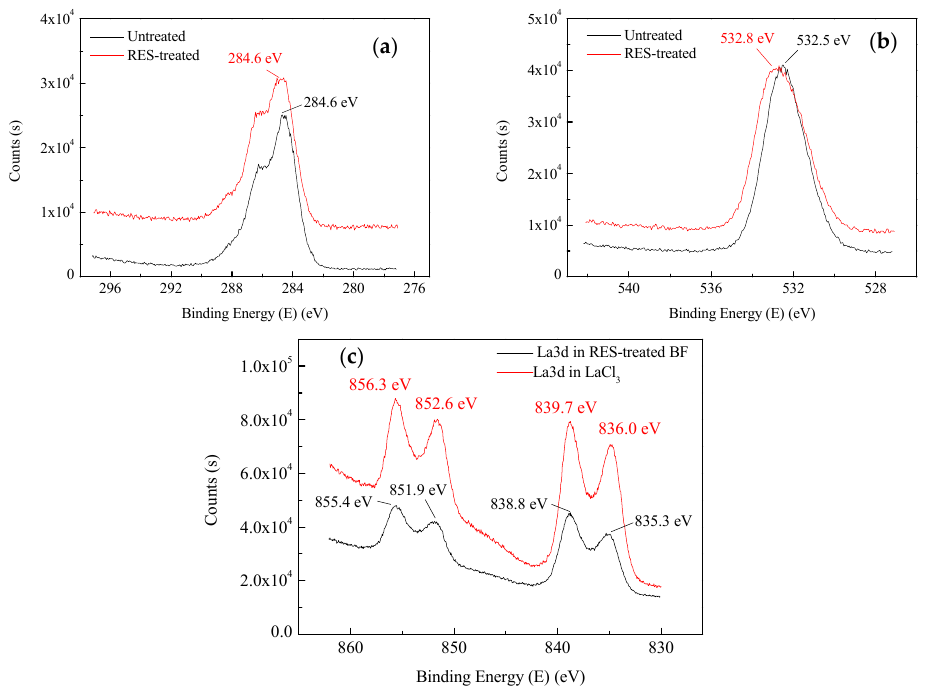
Figure 10. Narrow-scan photoelectron spectra of elements: ( a ) XPS spectra of C1s; ( b ) XPS spectra of O1s; ( c ) XPS spectra of La3d.